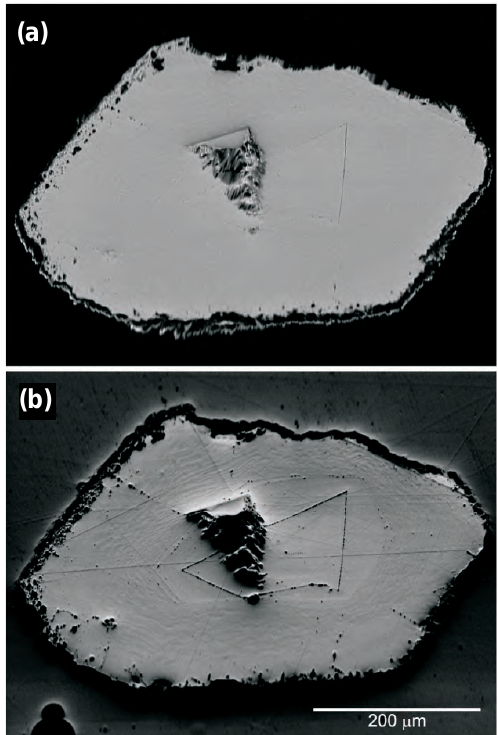
Figure 10. FSD image of a transversely sectioned, partly recrys- tallised calcite spicule acquired in (a) chemical contrast, (b) orien- tation